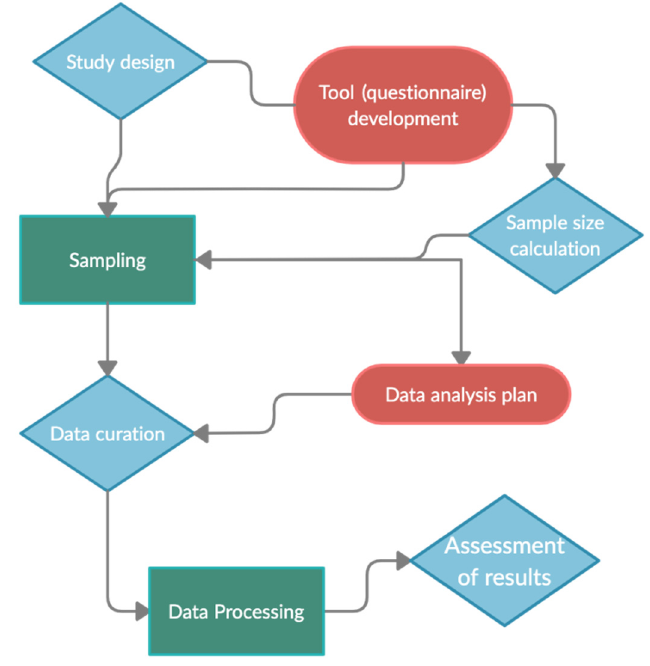
Figure 1. Data Flow Chart (DFC) describing the methodological steps of the study.